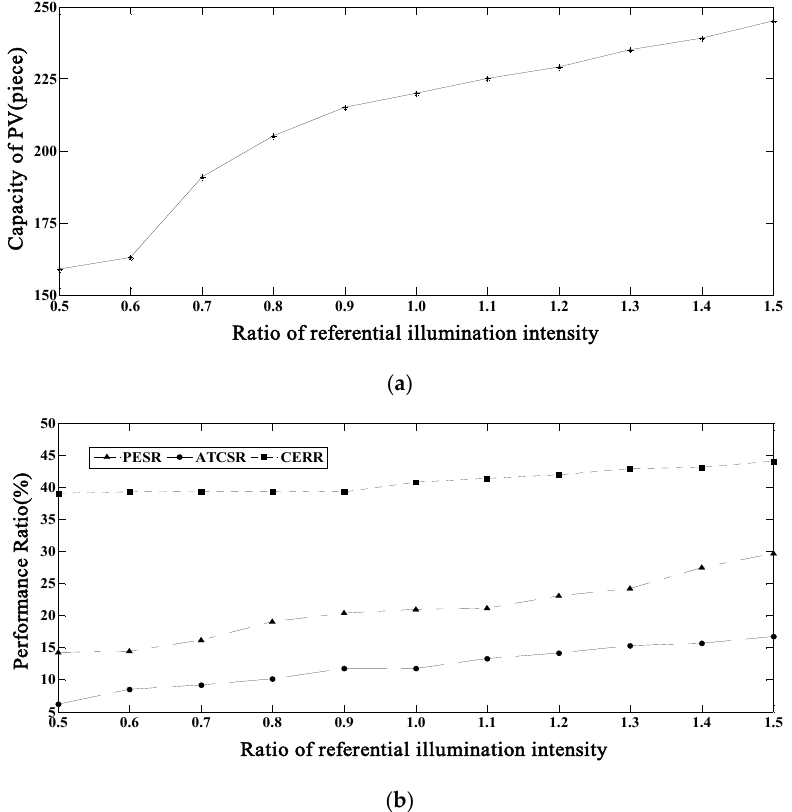
Figure 10. Sensitivity analyses of illumination intensity. ( a ) Capacity of photovoltaic (PV) plates; ( b ) performance ratio.